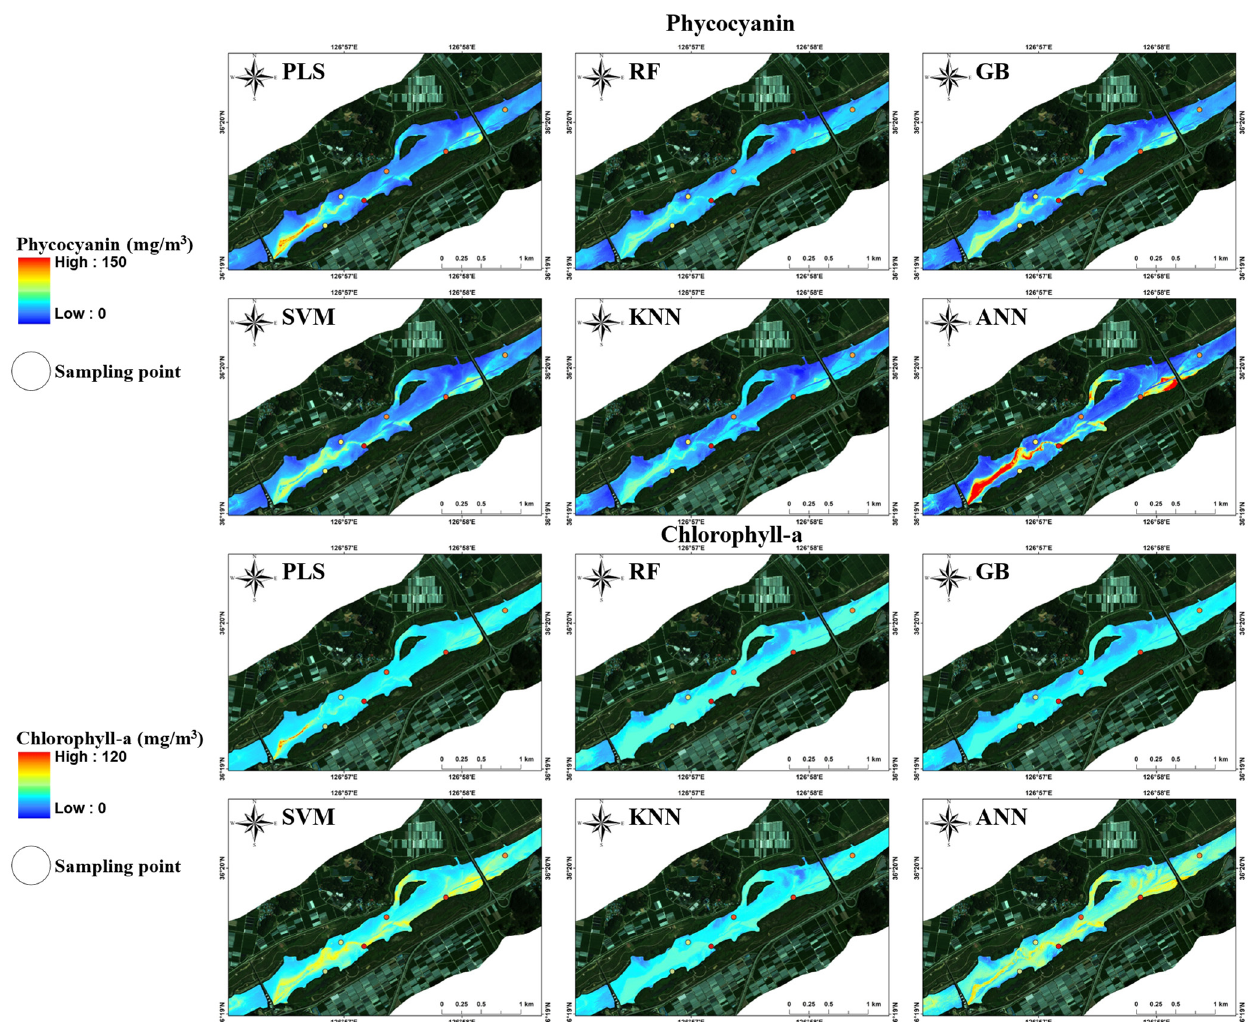
Figure 5. Comparison map of phycocyanin (PC) and chlorophyll-a (Chl-a) concentration distribution by six optimized regression models from hyperspectral imagery near Baekje weir on 12 August 2016, when cyanobacteria were predominantly distributed; sampling point is marked with PC and Chl-a concentration.